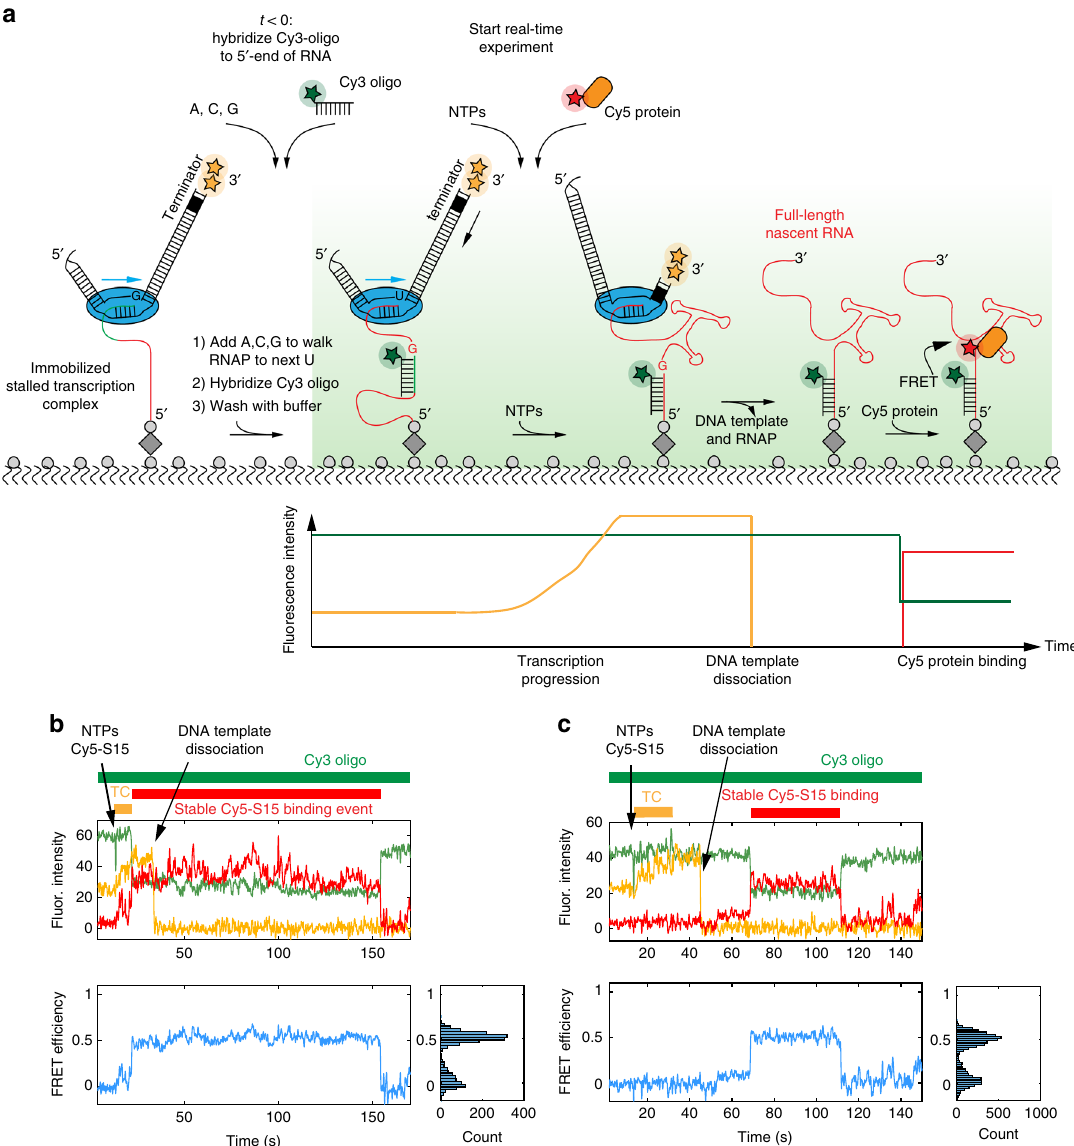
Fig. 6 Experiment to detect true co-transcriptional binding. a Experimental setup for detection of speci fi c Cy5-S15 protein binding during transcription (see Methods for more details). b , c Representative single-molecule traces with fl uorescence intensity (top), FRET ef fi ciency (bottom) and its probability distribution (bottom right) for a single transcribing RNA molecule binding to 25 nM r-protein S15 in which Cy5-S15 binds before ( b ) or after ( c ) DNA template dissociation. The periods of transcription elongation (TC, orange), Cy5-S15 binding (red) and Cy3-oligo binding (green) are indicated as bars. The reagents were delivered at 12.3 s. A single laser at 532 nm was used to directly excite both Cy3 and Cy3.5